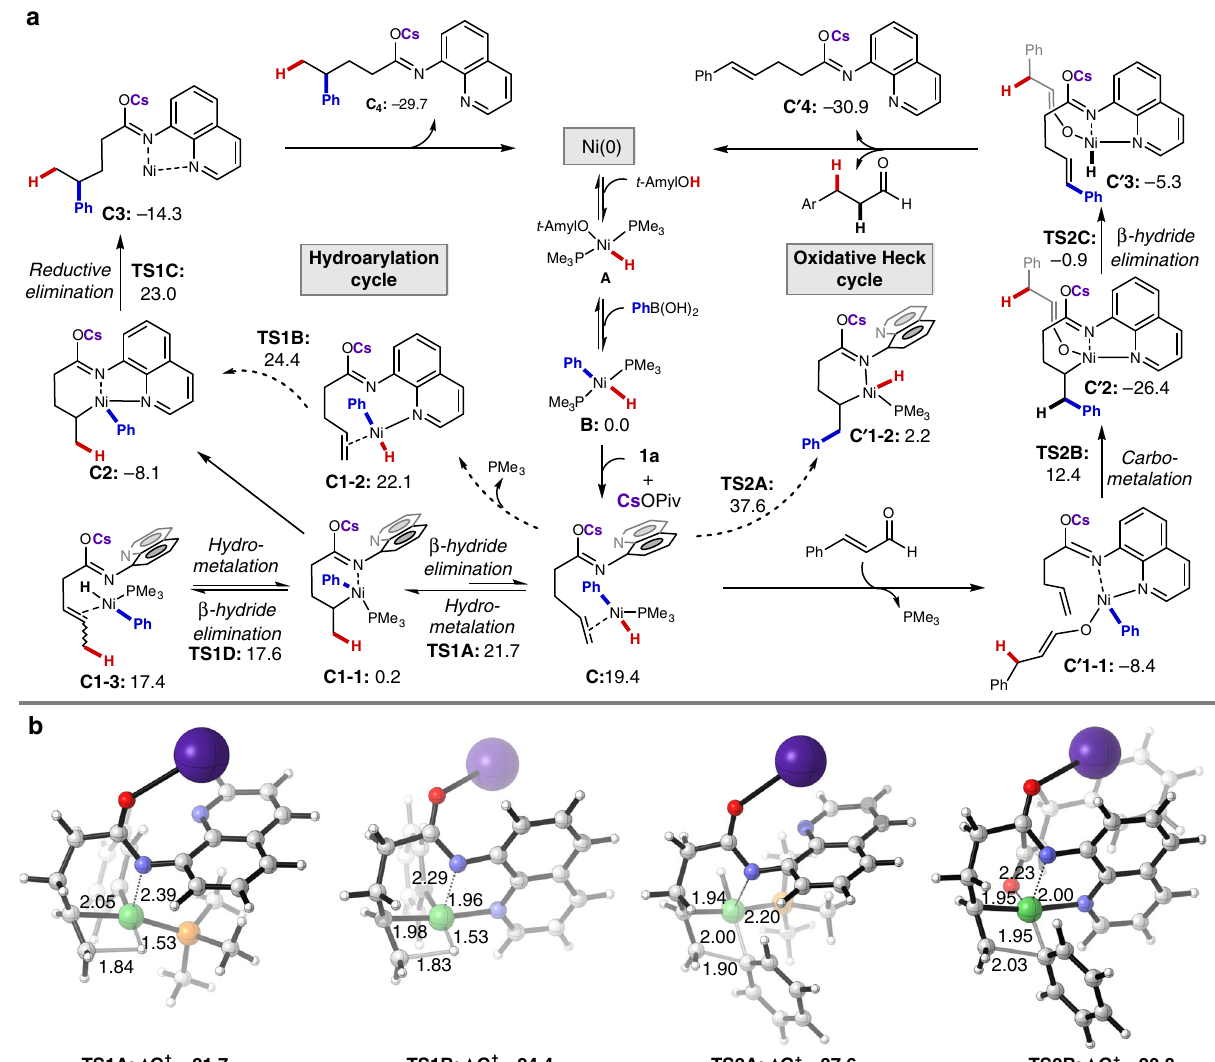
Fig. 5 DFT calculations for reaction mechanism. a Proposed catalytic cycle with free energies computed by DFT (kcal mol − 1 ). b Structures of transition states TS1A , TS1B , TS2A , and